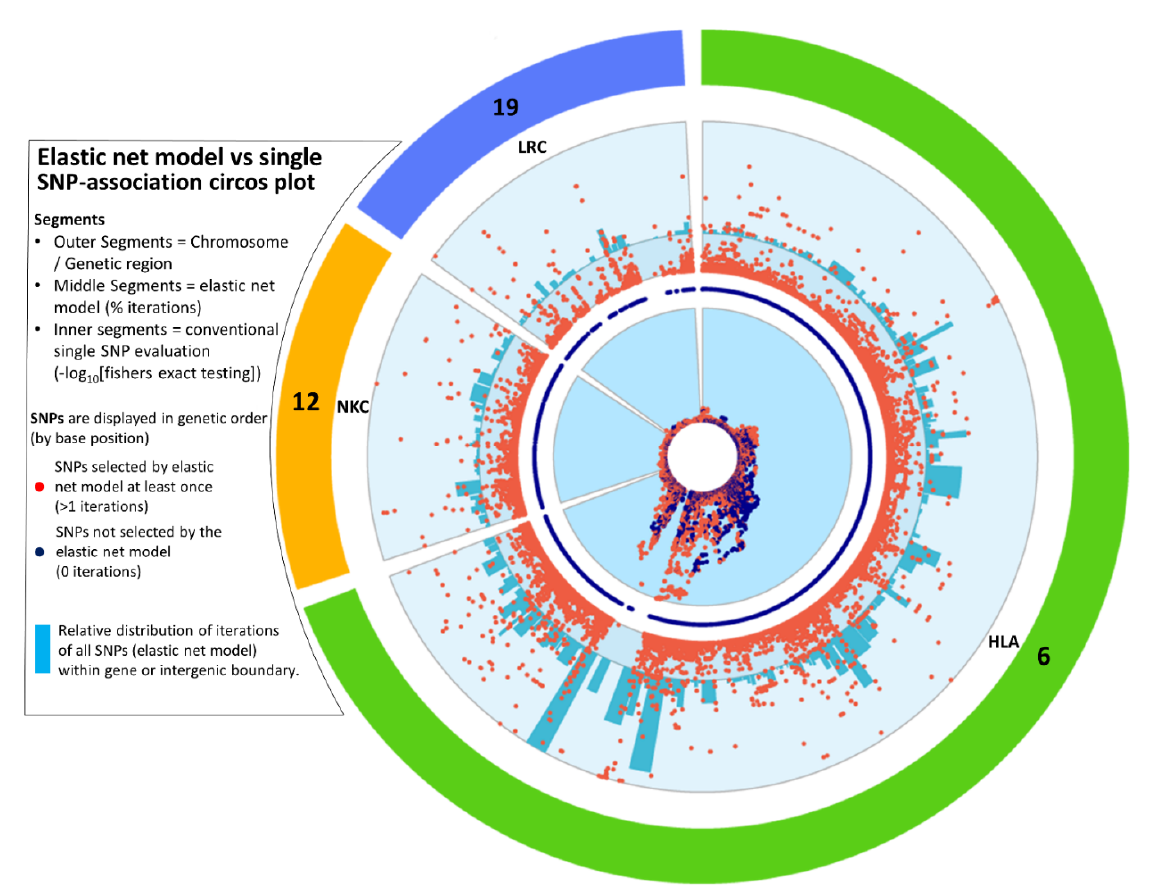
Figure 4. Circos plot for the imputed SNPs from the ANZgene dataset, extracted from the HLA (green), NKC (orange) and LRC (blue) loci on chromosomes 6, 12 and 19, respectively. Each dot represents a single SNP plotted clockwise in bp order (see Methods for region boundaries). This plot compares one-at-a-time SNP evaluation using P values against our elastic net model for the exact same set of SNPs. The innermost ring is the -log10 P values from Fisher’s Exact testing (a circularised Manhattan plot). The values range from 0 to the outer edge representing the lowest P value (65.3). SNPs in blue represent those that were never selected by elastic net with bootstrapping (0 out of 3000 iterations), while orange signifies SNPs that were selected by elastic net with stabilisation by iterative subsampling ( ≥ 1 out of 3000 iterations). The outer ring with orange dots, represents the percentage of iterations that each SNP was selected by elastic net with 3000 iterations, ranging from 0 to 100 at the outermost edge. The middle ring of blue SNPs indicates the position of SNPs that were never selected by elastic net. Each dot representing the elastic net result is aligned at the same degree as the dots representing the -log10 P value in the innermost circle. The outermost ring with blue bars represents the combined contribution of all the iterations of each SNP (from elastic net with bootstrapping) within each genomic boundary relative to the total number of iterations, given as a percentage. The scale ranges from zero to 4.17%, which is the largest value representing the intergenic region between HLA-DQB1 and